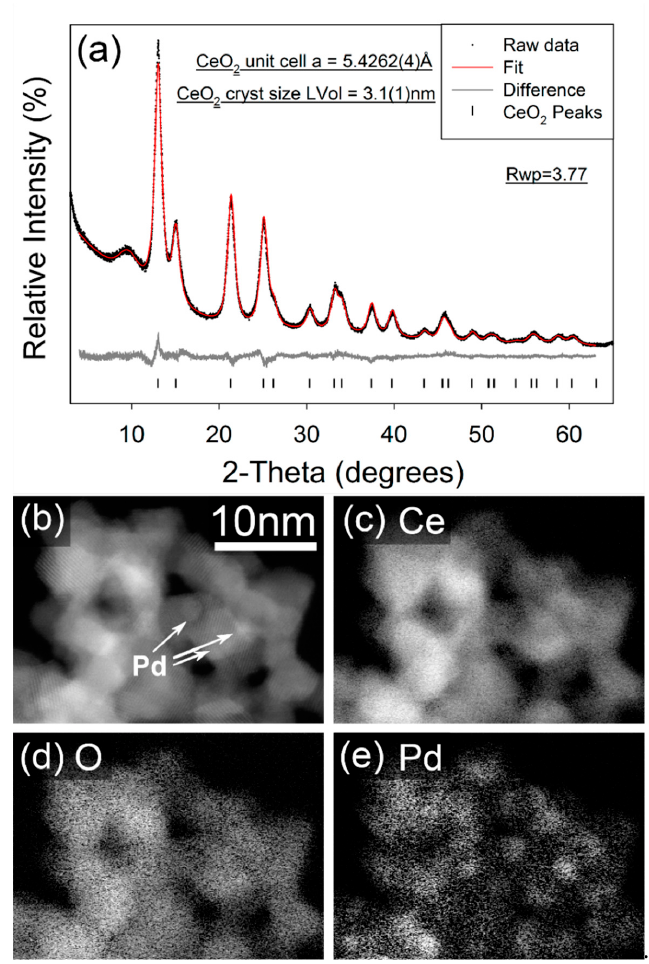
Figure 3. ( a ) Fitted X-ray powder diffractograms for FSP synthesized FSP Pd/CeO 2 . Data were collected in capillary transmission mode using a Mo-K α source and modelled using a Rietveld-type